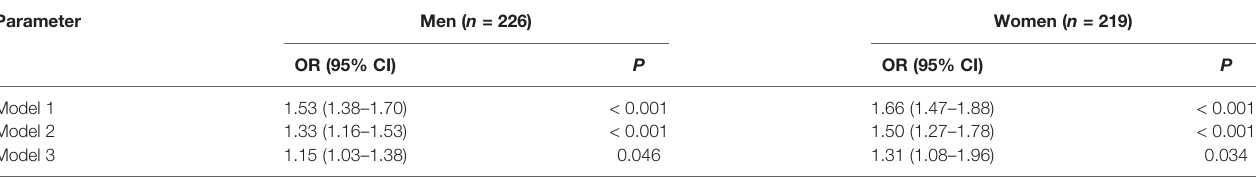
TABLE 4 | Binomial logistic regression analysis adjusted odds ratios (95% CIs) of PrFT in newly diagnosed T2DM divided by sex. Parameter